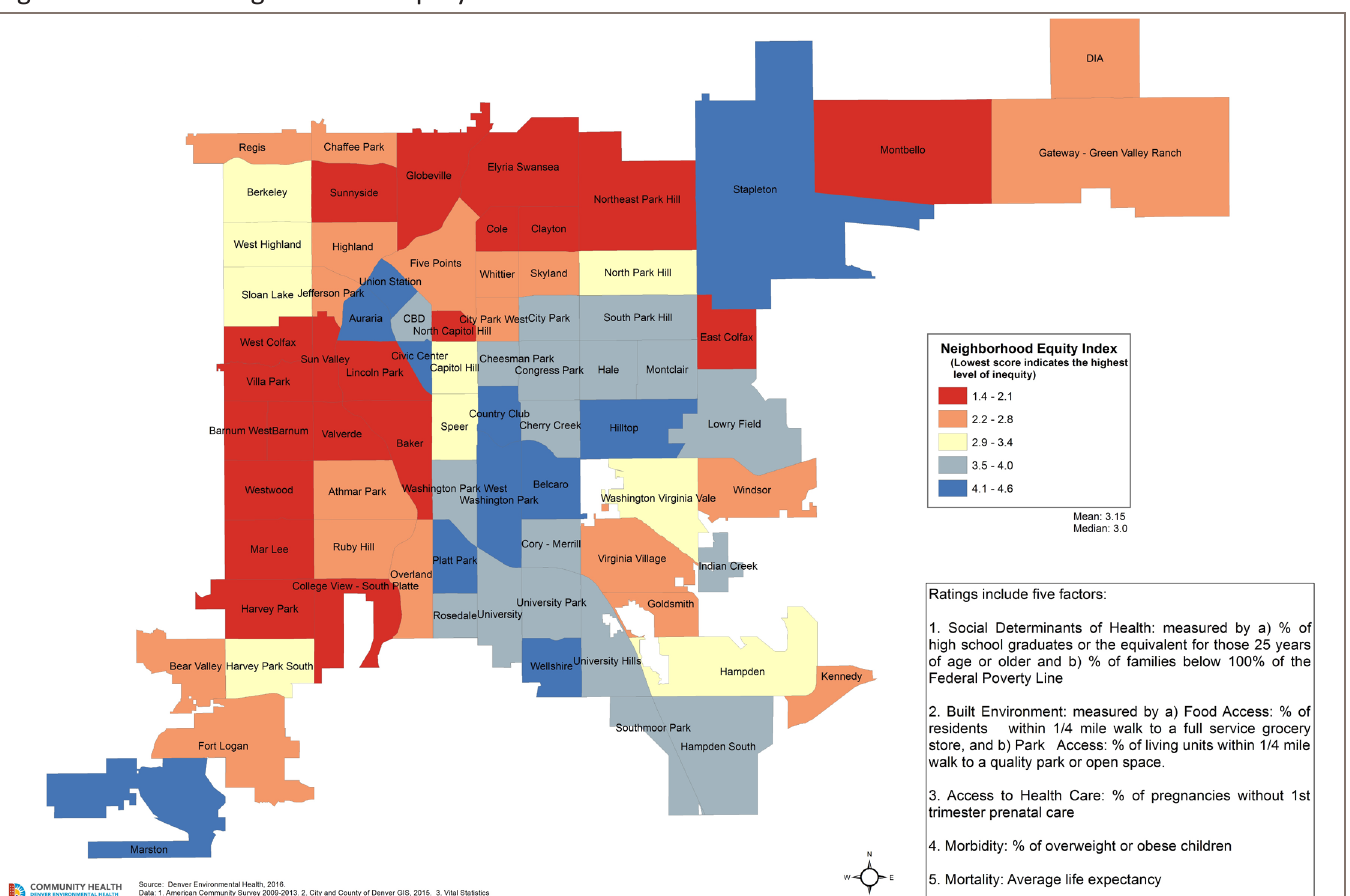
Figure 4: Denver Neighborhood Equity